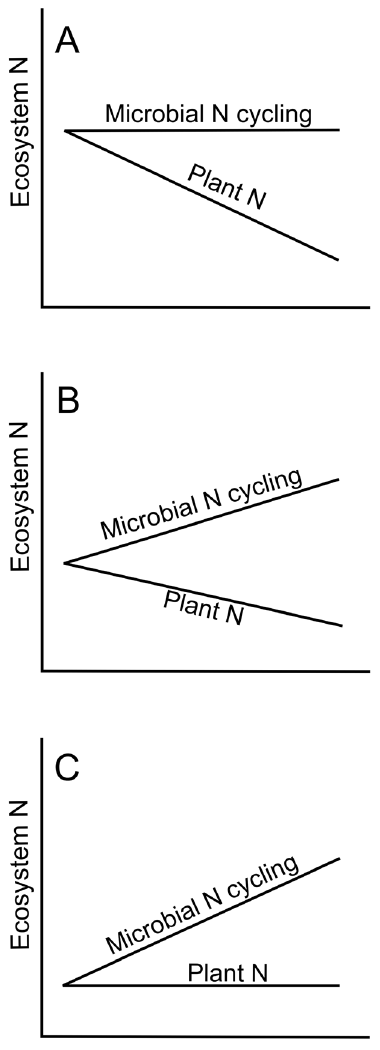
Figure 1. Conceptual models of plant and microbial controls of soil DIN. Our measure of R*, soil DIN, could be affected by A plant uptake, B plant uptake and microbial N cycling, or C microbial N cycling. See Introduction for details.